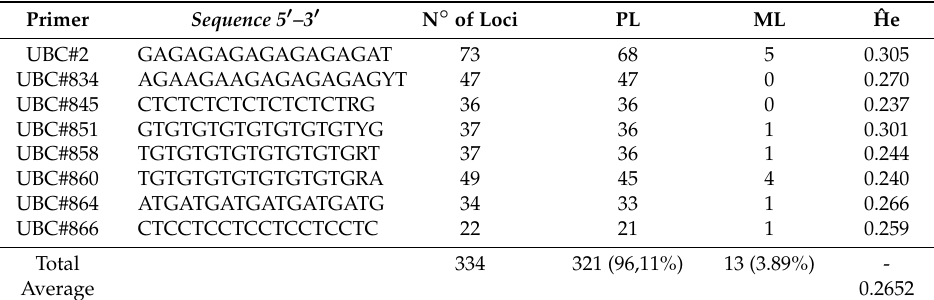
Figure 4. ( A ) Non-denatured polyacrylamide gel (8%) showing the amplification products related to the ISSR UBC2. The distinctive fingerprint of each species studied is shown. Column M corresponds to a molecular weight marker (GE Healthcare 50 pb). Lanes 1–5, 8–14, and 11 (amplified in duplicate) correspond to the taxon X. sagittifolium ; channel 9 corresponds to X. undipes (amplified in duplicate), channel 10 corresponds to X. violaceum (amplified in duplicate). Lanes 6, 7, and 12 correspond to C. esculenta . (Source: Laboratory of Plant Genetics/University of São Paulo, Campus of Ribeirão Preto, Brazil); ( B ) Dendrogram based on the UPGMA algorithm showing the genetic similarity of the specimens of the four analyzed species. Table 2. Characteristics and sequences of the inter-simple sequence repeat (ISSR) primers used in the genetic analysis of specimens of four species of Araceae. PL = polymorphic loci, ML = monomorphic loci. Ĥ e = Nei Genetic Diversity. R = (A,G), Y = (C,T). Primer Sequence 5 ′ –3 ′ N° of Loci PL